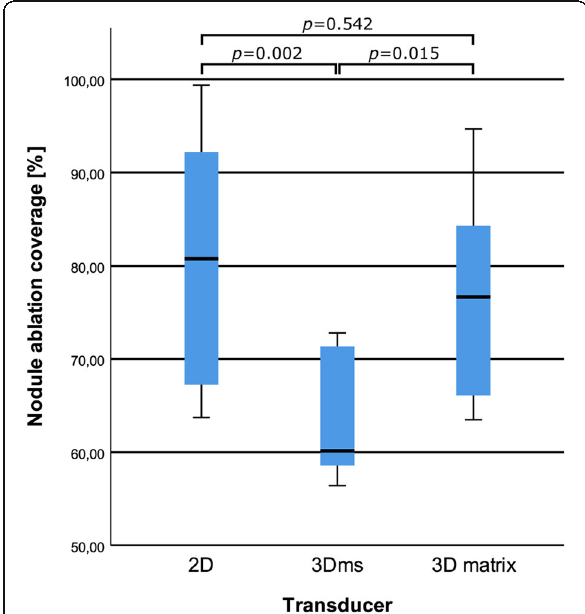
Fig. 6 Boxplot of the nodule ablation coverages per transducer with corresponding p values